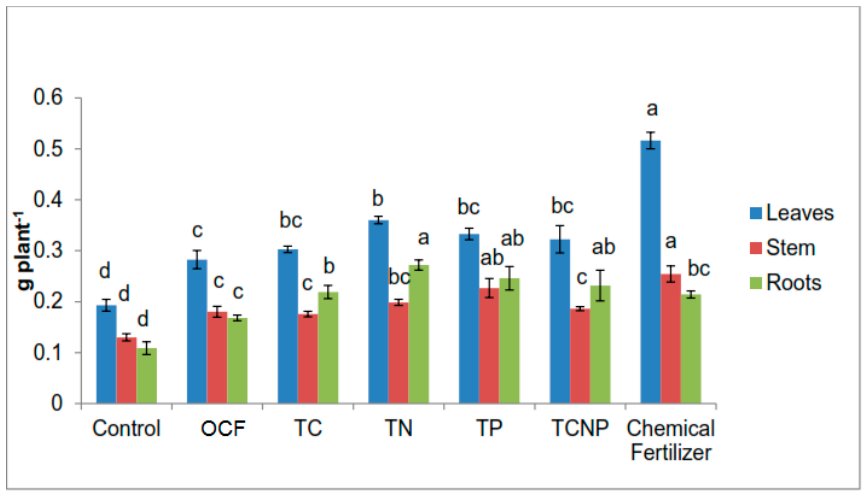
Figure 3. E ff ect of treatments on nitrogen uptake of maize plants. Di ff erent letters for similar colored bars indicate significant di ff erence between treatment means using Tukey’s test at P ≤ 0.05. Nitrogen uptake was calculated by multiplying nitrogen concentration with the dry weight of the respective plant parts.